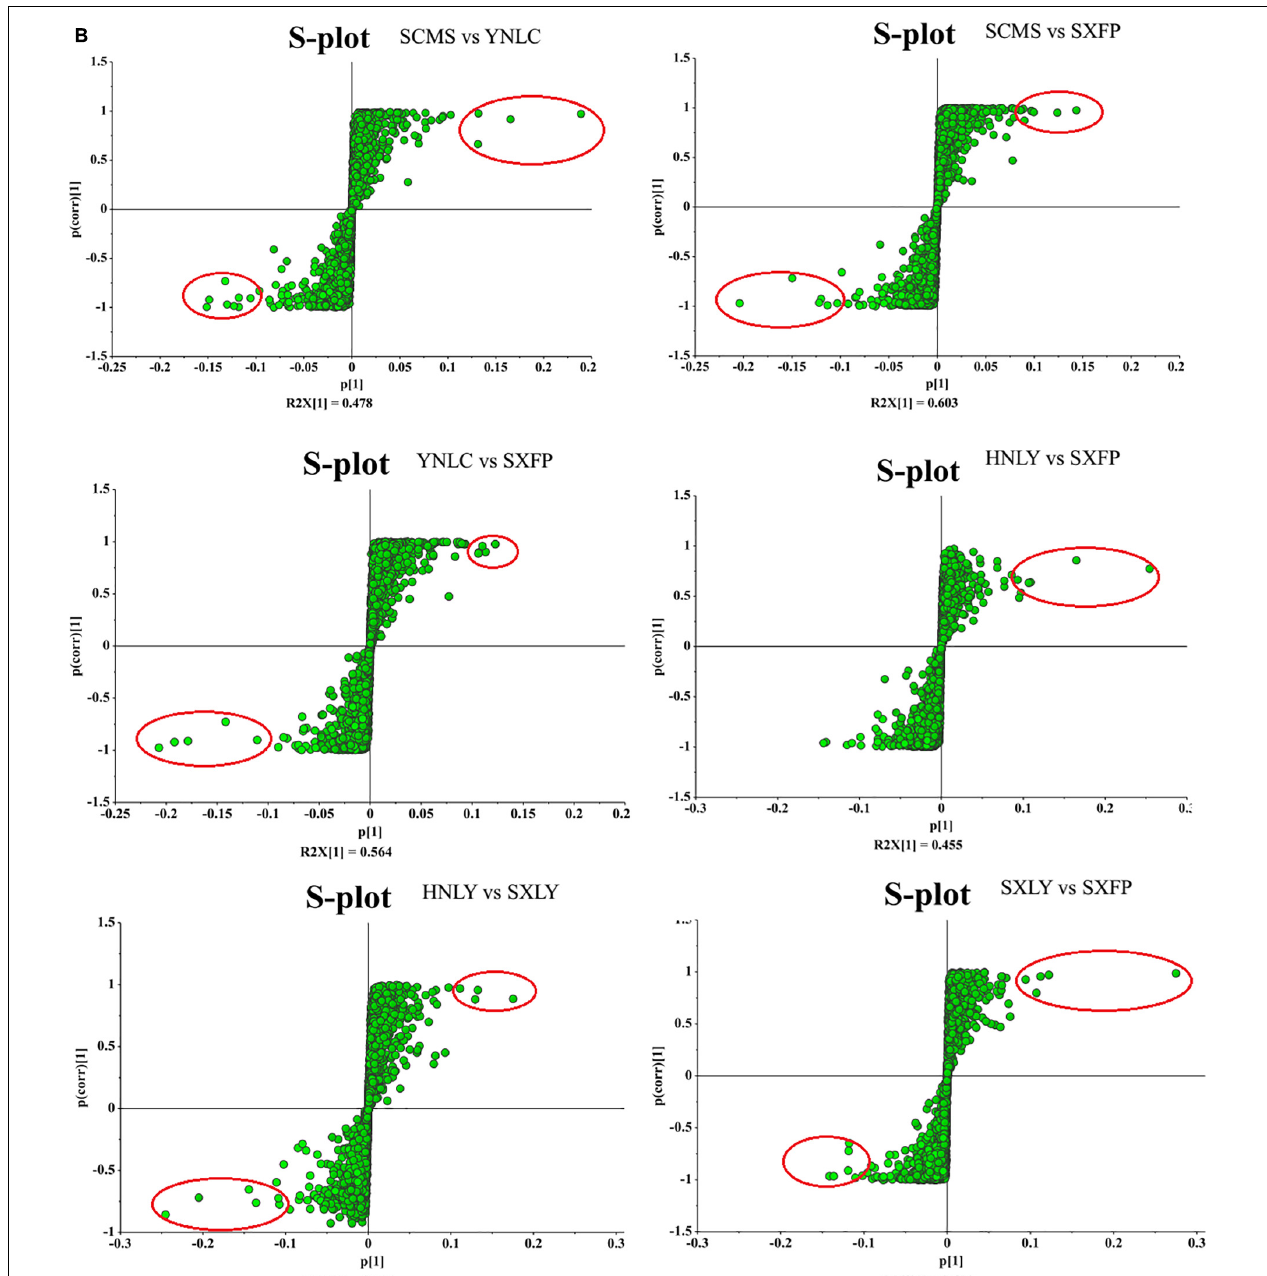
FIGURE 3 | (A) S-plot analysis of different origins of P. sibiricum (positive ion mode). (B) S-plot analysis of different origins of P. sibiricum (negative ion